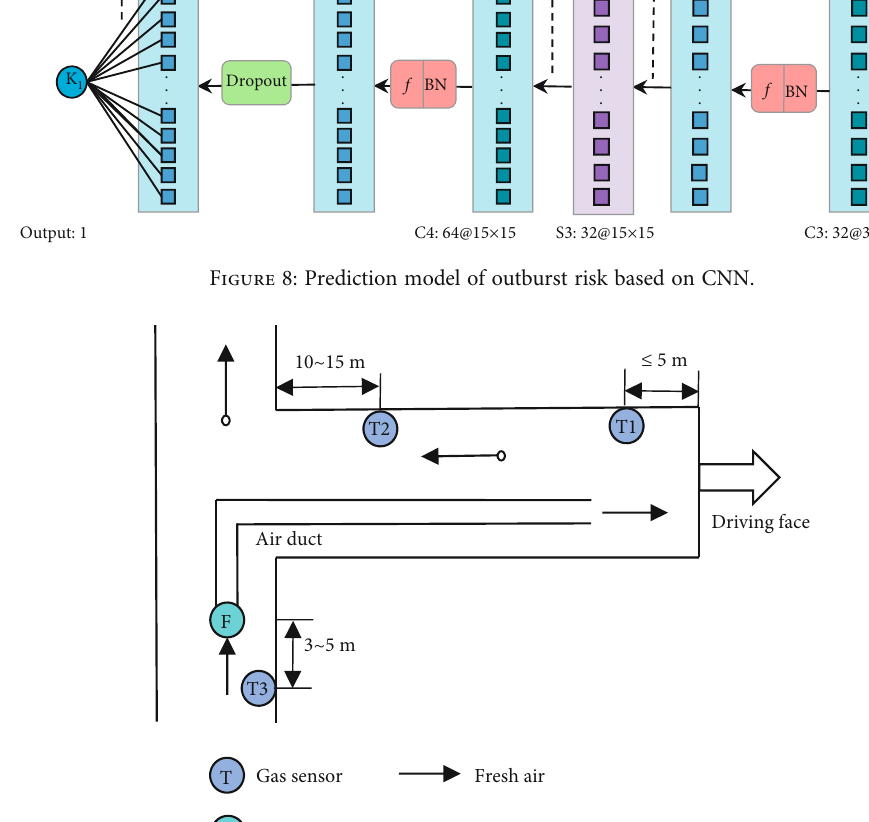
Figure 9: Layout of gas sensors in blasting driving